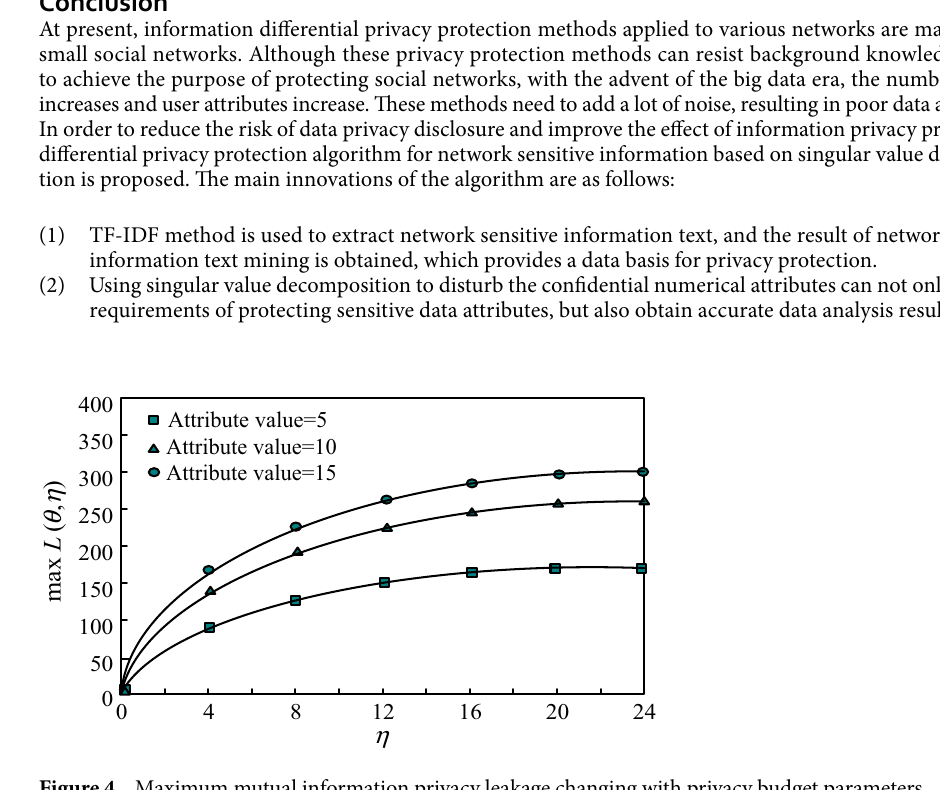
Figure 4. Maximum mutual information privacy leakage changing with privacy budget